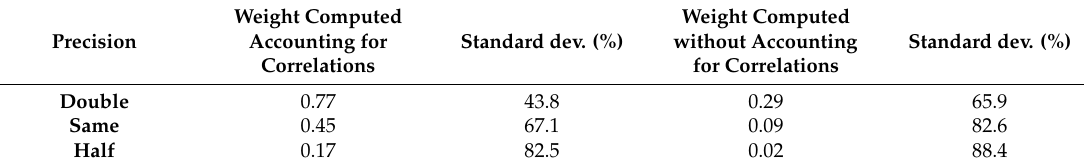
Table 8. Weight allocated to an 11th independent estimate following 10 correlated (0.8) estimates. In the second and third columns the weights account for correlated errors; in the last two columns error correlations are ignored. “Double” precision of the 11th estimate means 50% standard deviation compared to each of the 10 previous, “same” precision means 100% standard deviation, and “half” means 200%. Weight Computed Weight Computed Precision Accounting for Standard dev. (%) without Correlations